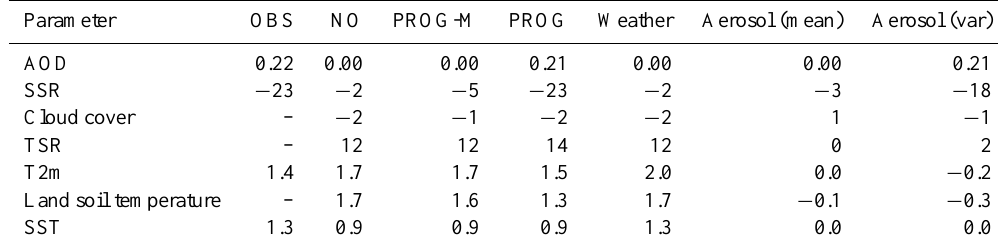
Figure 12. Average AOD (a) , downward SSR (b) , cloud cover (c) , downward TSR (d) , 2m temperature (e) and soil temperature (f) differences between the dusty and the set of all the days in 14 stations (presented in Table 1) in summer 2012 for the NO, PROG-M and PROG simulations, as well as observations (AERUS-GEO for AOD, ground-based measurements for the other parameters). For Lampedusa and the buoys in the Gulf of Lions and Azur, 2m temperature has been replaced by SST. Table 7. Same as Table 6 but for the average over the 14 stations defined in Table 1. Parameter OBS NO PROG-M PROG Weather Aerosol